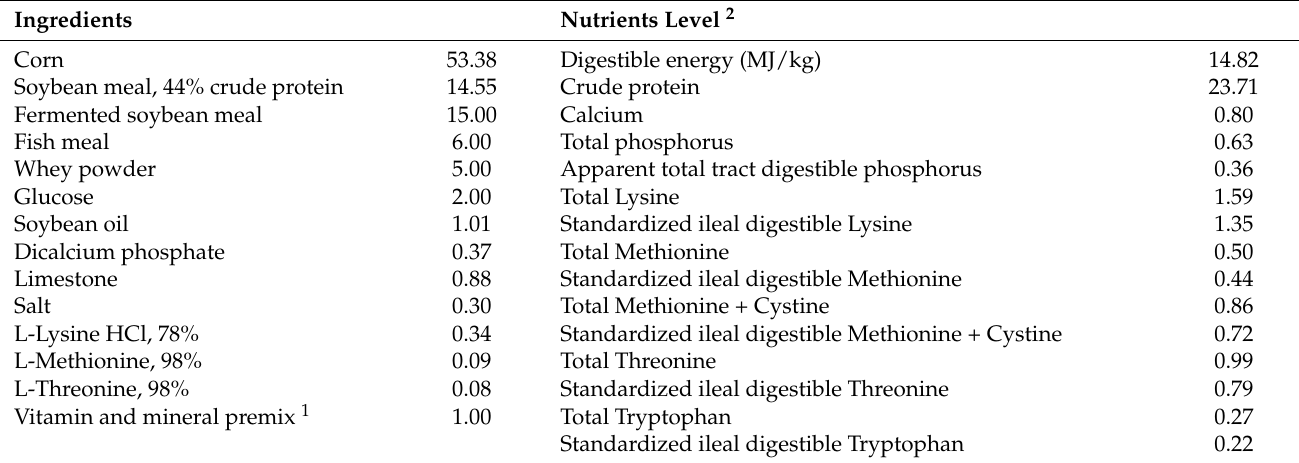
Table 1. Ingredient composition of experimental diets (%, as-fed